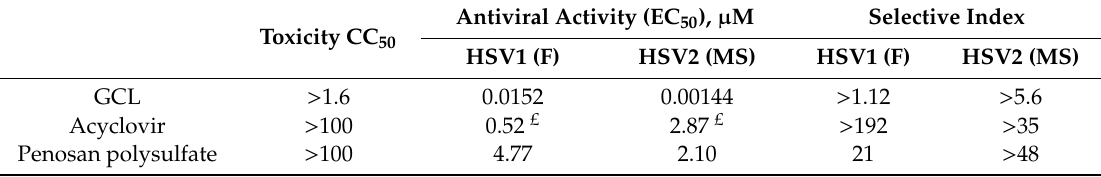
Table 6. Antiviral activity of Grateloupia chianggi lectin (GCL) against herpes simplex virus